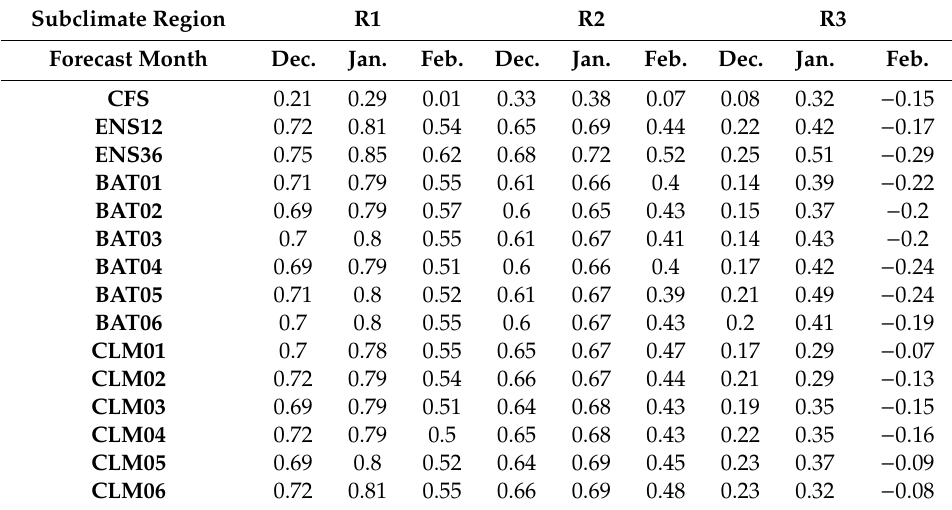
Table 3. Correlation coefficients for the mean monthly temperature (for December, January, and February) between the RegCM4 predictions and observations in 1998–2018 from CFS, ENS12, ENS36, and single forecasts for di ff erent subclimate regions at the four-month forecast